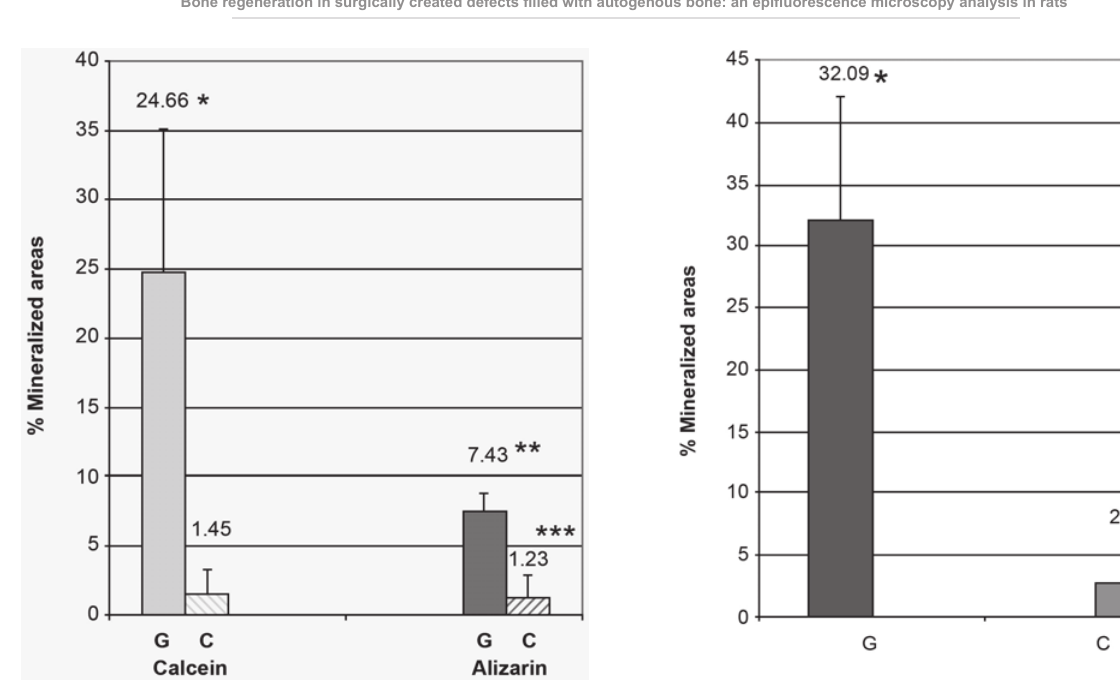
Figure 11- Percentage reached by calcein and alizarin in relation to the total area (TA). (G = Graft Group; C = Control Group). Results are expressed as mean ± standard deviation *Differs significantly from the Control group labeled by calcein (P = 0.008) (Mann-Whitney Test) **Differs significantly from the Graft Group labeled by calcein. (P = 0.008) (Mann-Whitney Test) *** Differs significantly from the Graft Group labeled by alizarin. (P = <0.001) (T Test)